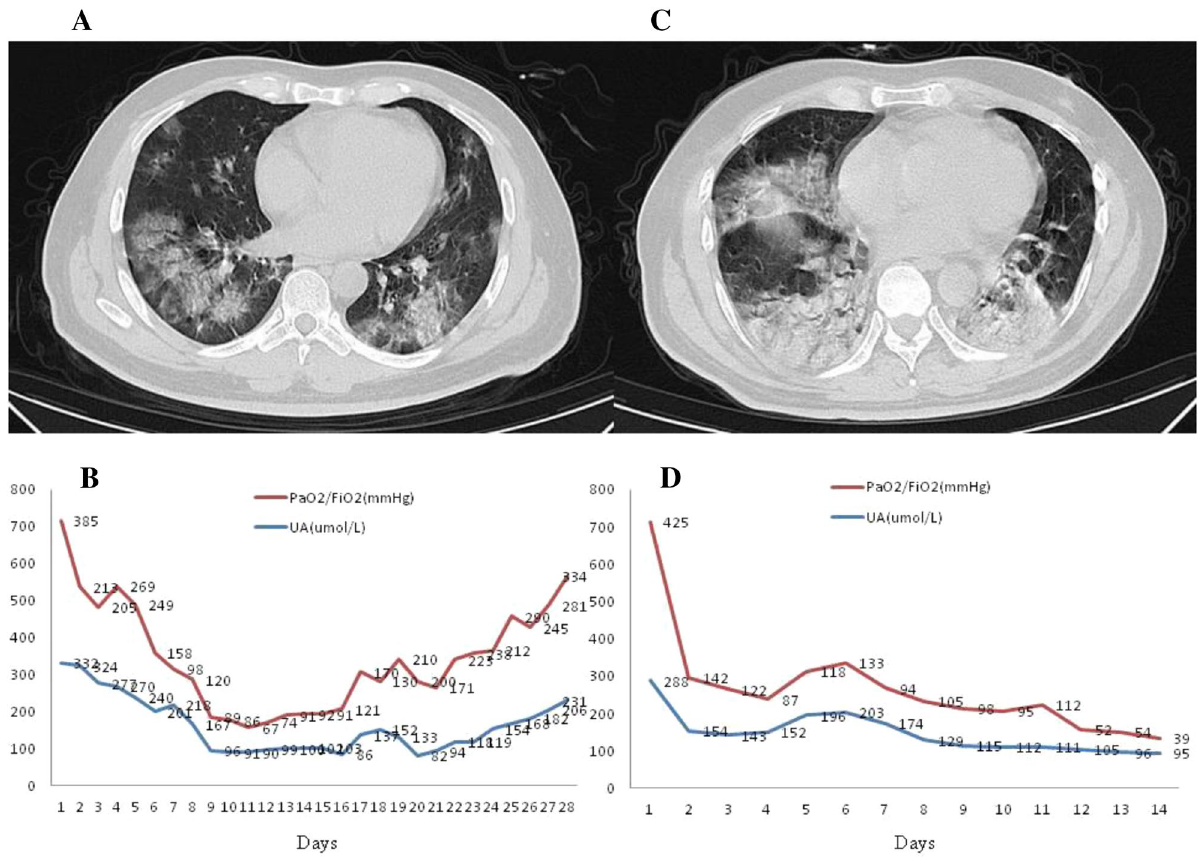
Figure 1. Chest CT images of COVID-19 patients and stacked trend chart of blood UA levels and PaO 2 /FiO 2 . ( A ) and ( B ) a 60 year old survivor’s CT images and stacked trend chart, the time point of the CT taken was the